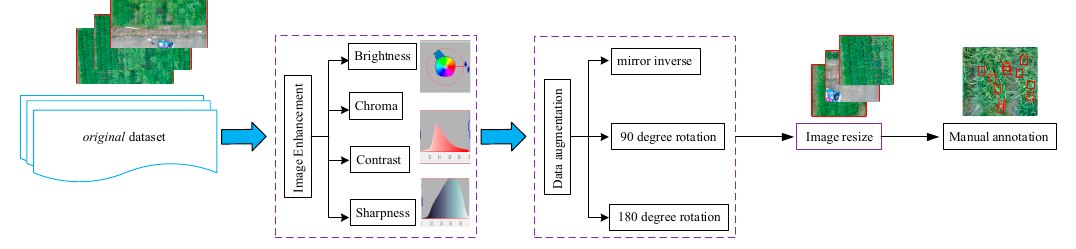
Figure 2. Flowchart showing data-preprocessing procedure.